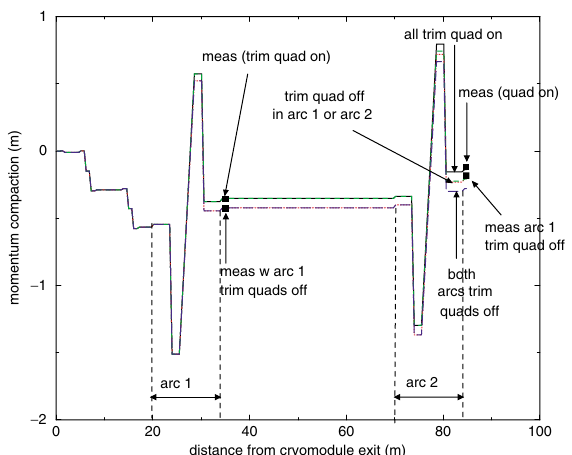
FIG. 10. (Color) Evolution of the linear momentum compaction along the beam line, from the linac exit to the linac entrance.